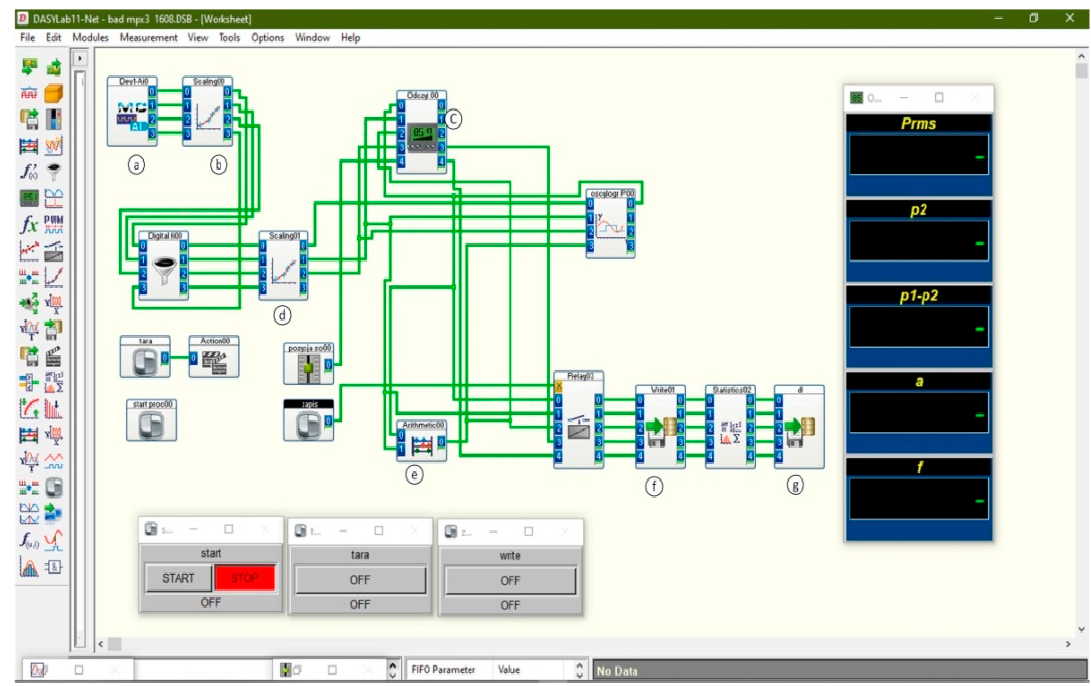
Figure 7. Measurement scheme used in the DASYLAB software.